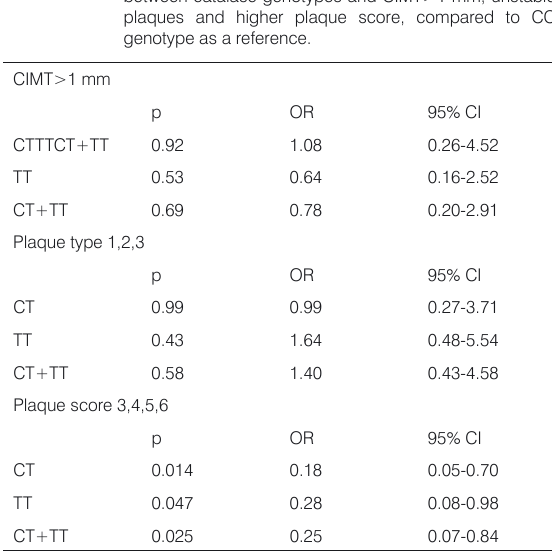
Table 4. Multiple logistic regression analysis for the association between catalase genotypes and CIMT>1 mm, unstable plaques and higher plaque score, compared to CC genotype as a